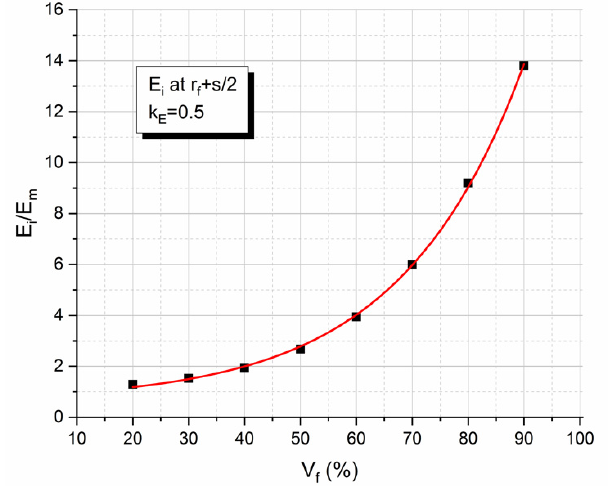
Figure 6. Variation of the relative interphase modulus E i /E m value corresponding to the midpoint of the fiber separation distance between two adjacent E-glass fibers with the fiber volume fraction.